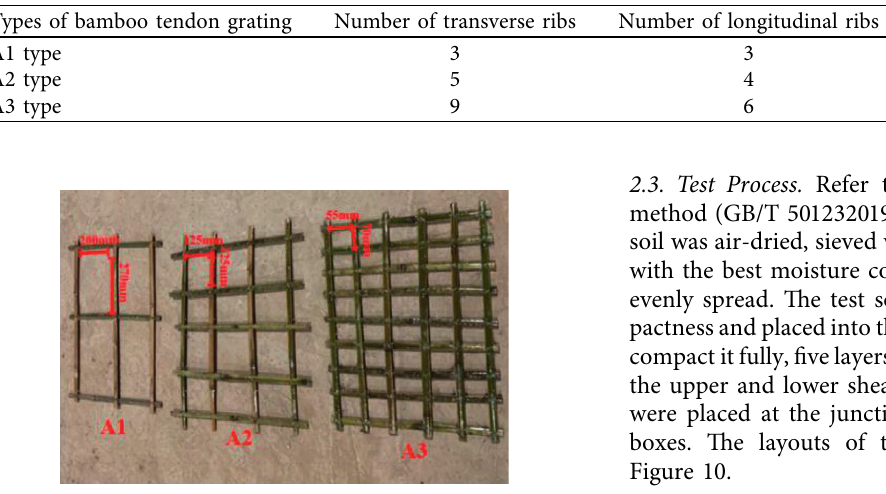
Figure 7: Bamboo tendon grating with different spacings.